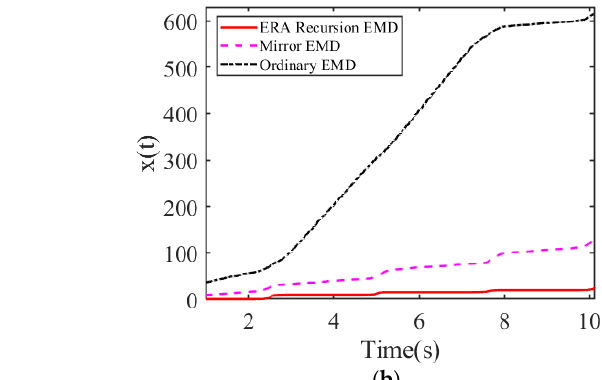
Figure 4. ( a ) The imf-1 results for each method. ( b ) The absolute error